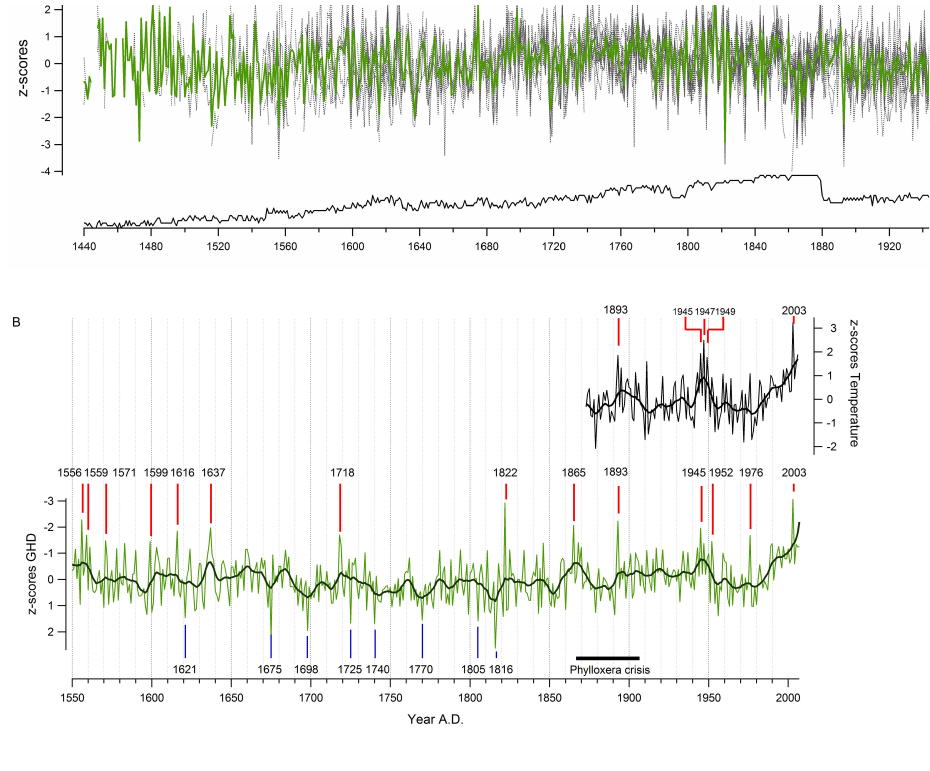
Fig. 6. (A) z -scores of the GHD-RCS (grey lines). The median of the z-scores is in green. The number of GHD-RCS available for the calculation of the z -score is reported. (B) Top panel: medians of the z-scores of the T AMJJAS max of the meteorological stations (network depicted in Fig. 3). The red and blue vertical lines correspond respectively to the years of early and late harvests. Bottom panel: medians of the z -scores of the GHD-RCS. The red vertical lines correspond to the five highest values. The 11-yr running means are reported as bold lines in each